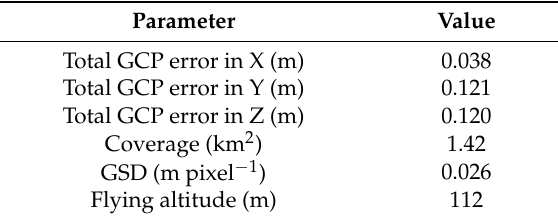
Table 2. Image co-registration model errors obtained for the GCPs used in the collection and processing of the imagery collected over Cockermouth, Cumbria, UK (13 December 2015), after Desmond (5–6 December 2015). RMSE stands for root mean squared error. All values were automatically derived from Photoscan Agisoft Pro version 1.1.6 (Agisoft LLC, St. Petersburg, Russia). GSD stands for ground sampling